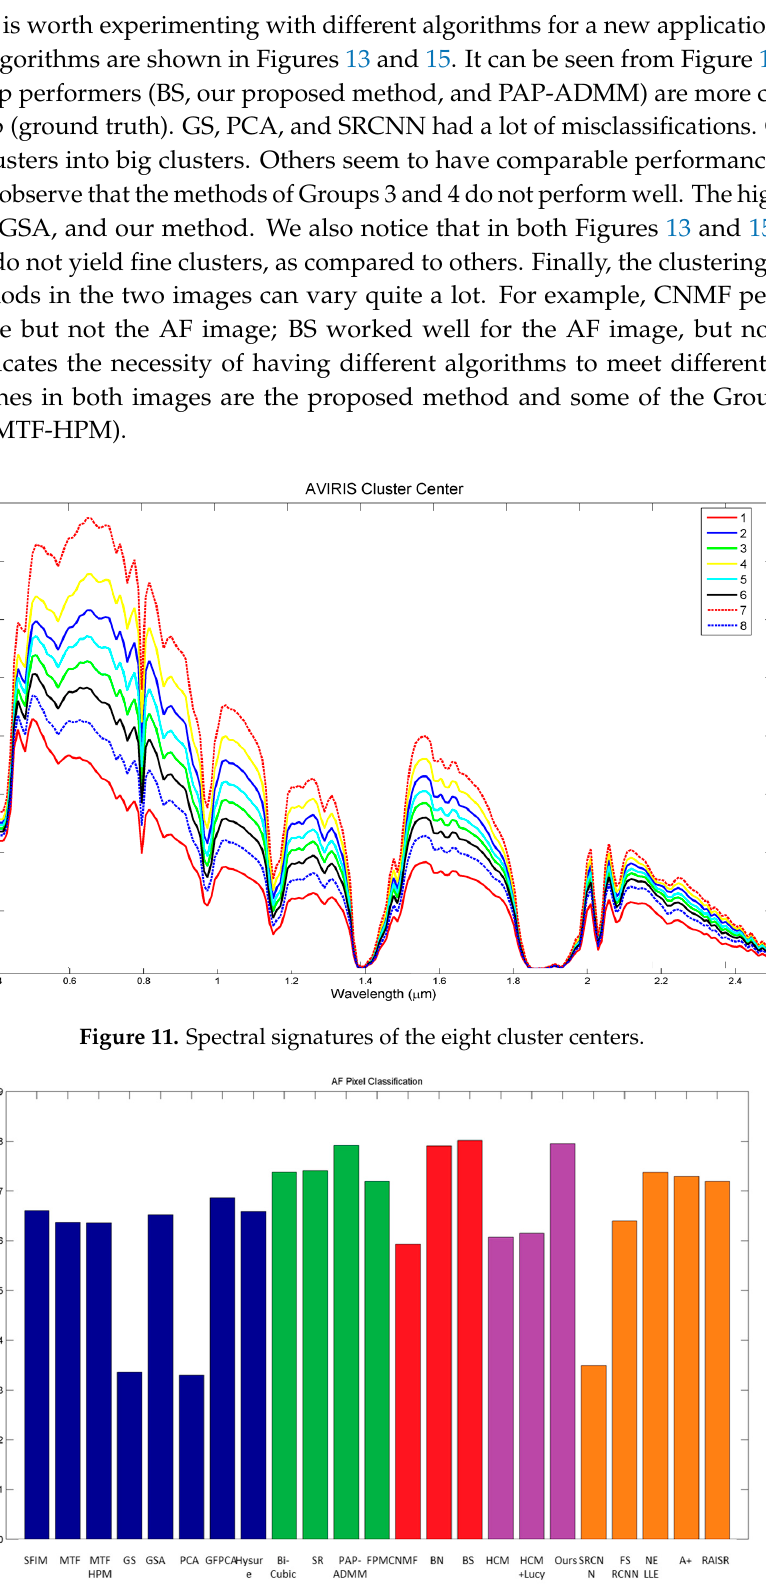
Figure 12. Pixel clustering accuracy using different algorithms for the AF dataset. Red: Group 1 methods; Blue: Group 2 methods; Green: Group 3 methods; Purple: HCM methods; Orange: Group 4 methods.